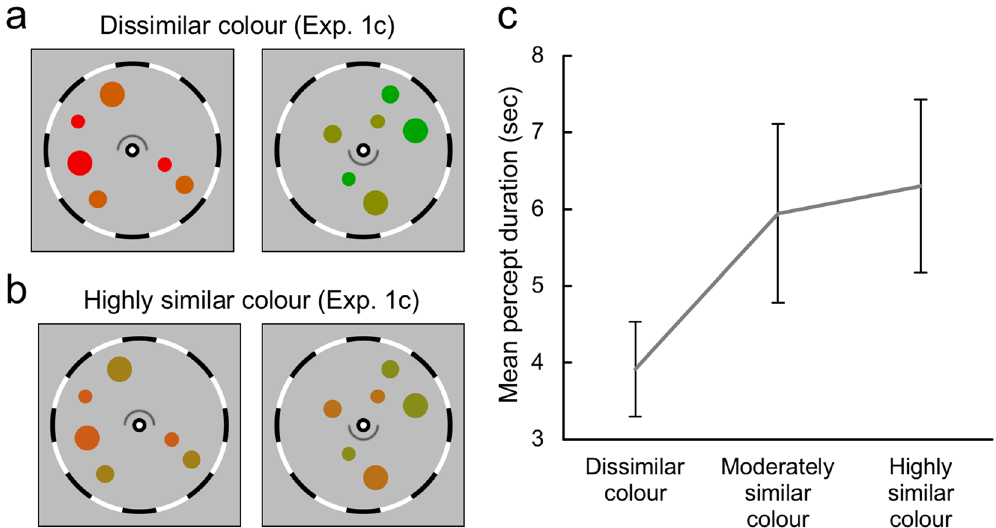
Figure 4. Conceptual example of dichoptic stimuli having dissimilar colour is shown in ( a ) and highly similar colour in ( b ). The mean durations of composite binocular percepts in Experiment 1c are plotted in ( c ). For the presentation purpose, coloured circles are drawn in relatively bigger sizes compared to the bulls-eye fixation points and fusion frames. In this experiment, circles in each eye could have one of the two colours yielding a total of four colours for the two eyes. Around the fixation point, upper and lower halves of a ring was presented in the separate eyes, and participants reported whether they saw an entire ring. Mean durations depending on the similarity between stimulus colour combinations are plotted in ( c ), and the raw data of participants’ responses are shown in Supplementary Figs S4 and S5. Error bars indicate the standard error of